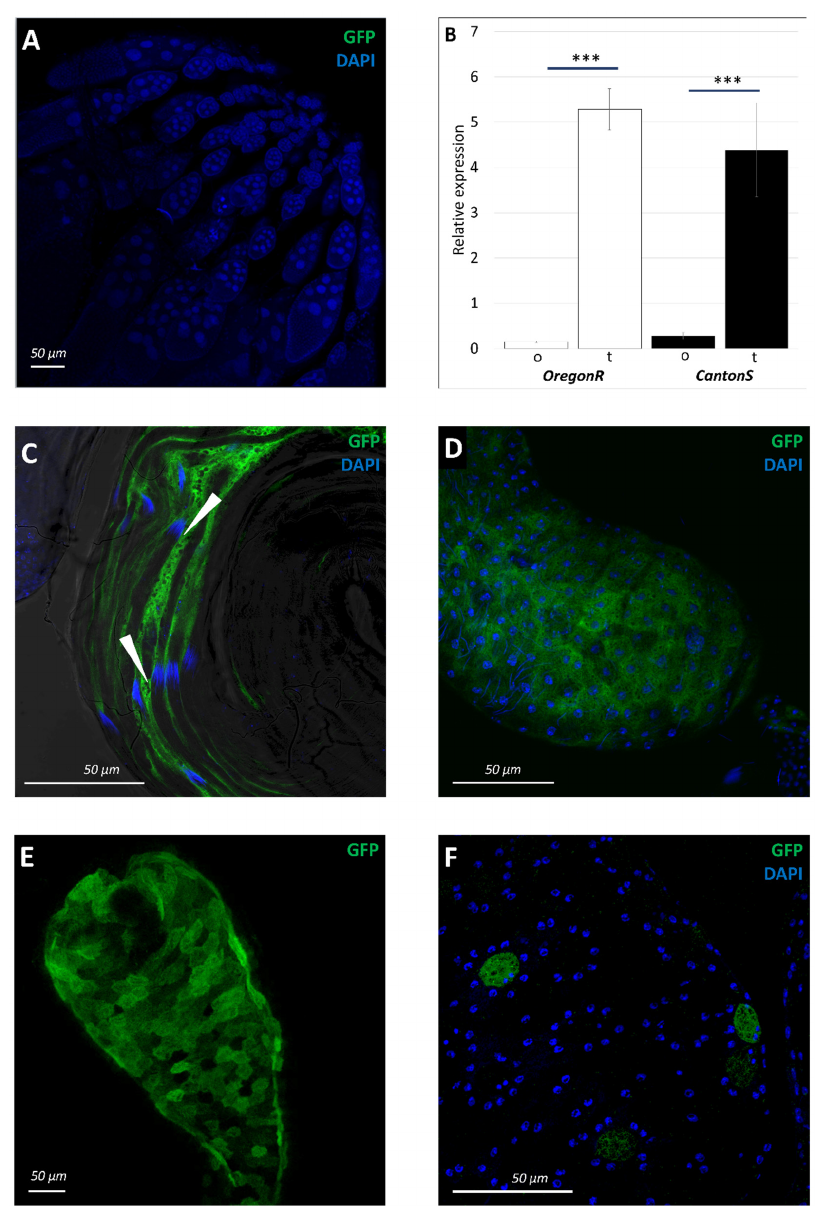
Figure 3. Analysis of sws expression in imago’s reproductive system. ( A ) Confocal image of the ovary of the female with sws-GAL4;UAS-CD8-GFP genotype. Nuclei are stained with DAPI (blue). ( B ) The relative level of sws transcripts in ovaries (o) and testes (t) of the wild type flies. The level of Gapdh2 mRNA is accounted as 1 in each sample. Mean and 95% CI are shown; Student t -test; *** p < 0.001; n = 9. Note that there is significantly higher sws mRNA level in testes compared to those in ovaries (about 100 folds difference). ( C – F ) Cells with GFP (green) expression in the male reproductive system of 2–7-day-old imago with sws-GAL4;UAS-CD8-GFP genotype. Confocal images of ( C ) proximal part of the testis, ( D ) seminal vesicle, ( E ) anterior ejaculatory duct, ( F ) accessory gland. Nuclei are stained with DAPI (blue). Note that inside a cyst, there is no green signal, whereas along cysts there is (marked with arrowheads in box ( C )). ( A , C – F ) Scale bar: 50 µm.